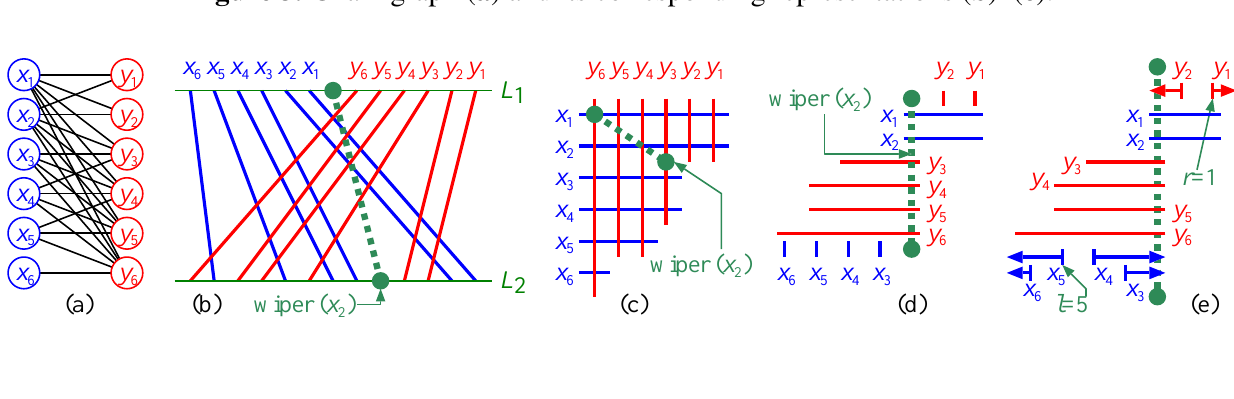
Figure 3. Chain graph ( a ) and its corresponding representations ( b )–( e